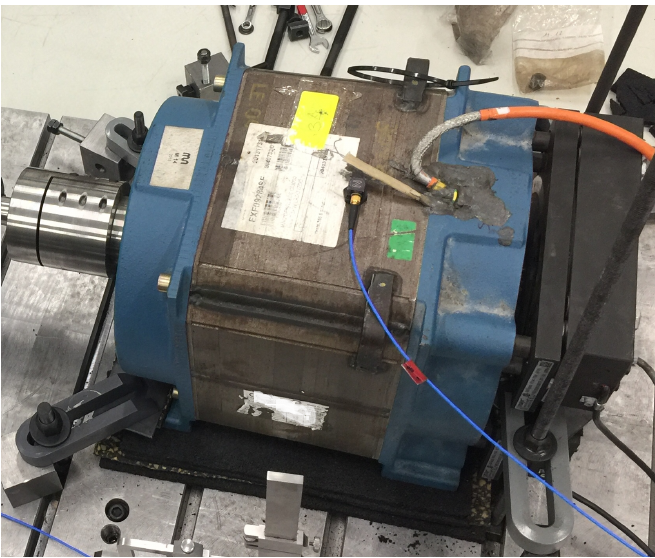
Figure 3. Experimental setup of the measurement of the vibration response.